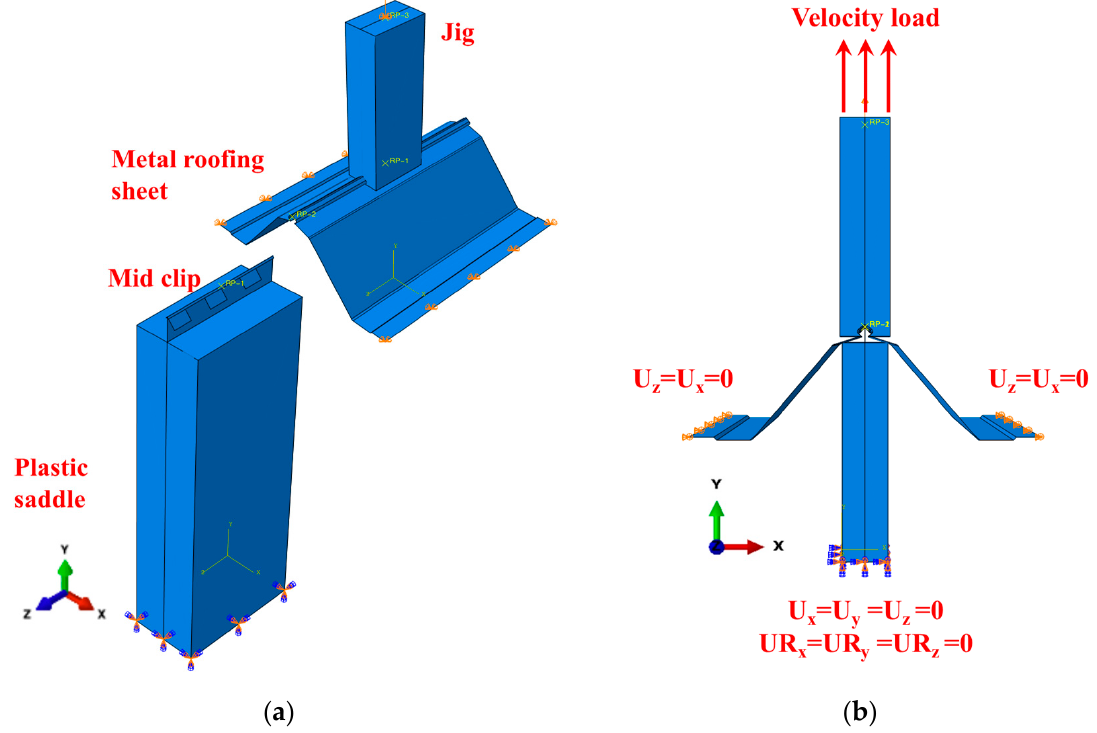
Figure 5. Finite element model of ( a ) the SSMR components and ( b ) the boundary conditions.